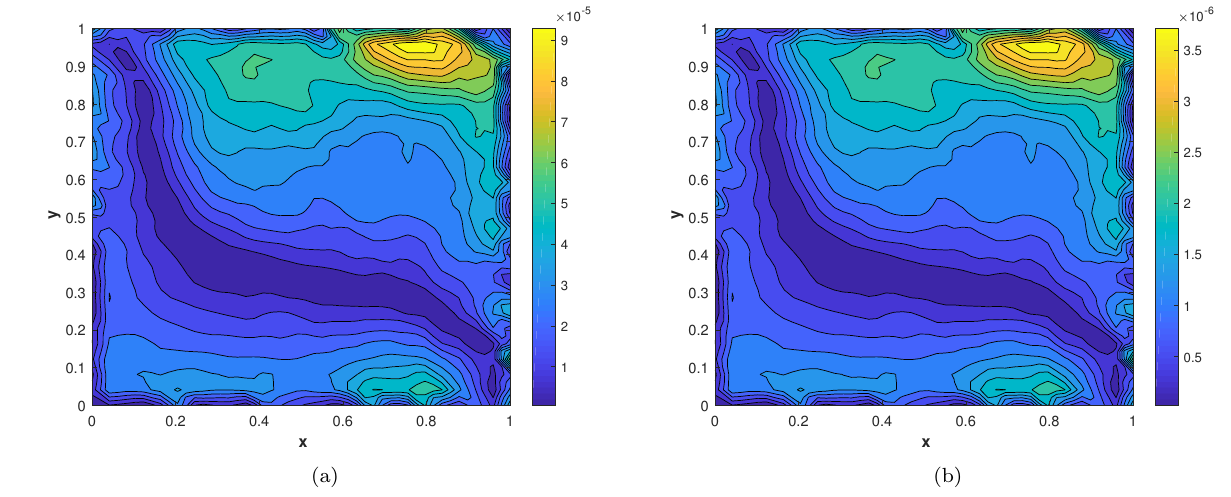
Figure 10: (a) Contour plot of Ab Error . (b) Contour plot of Rms Error .